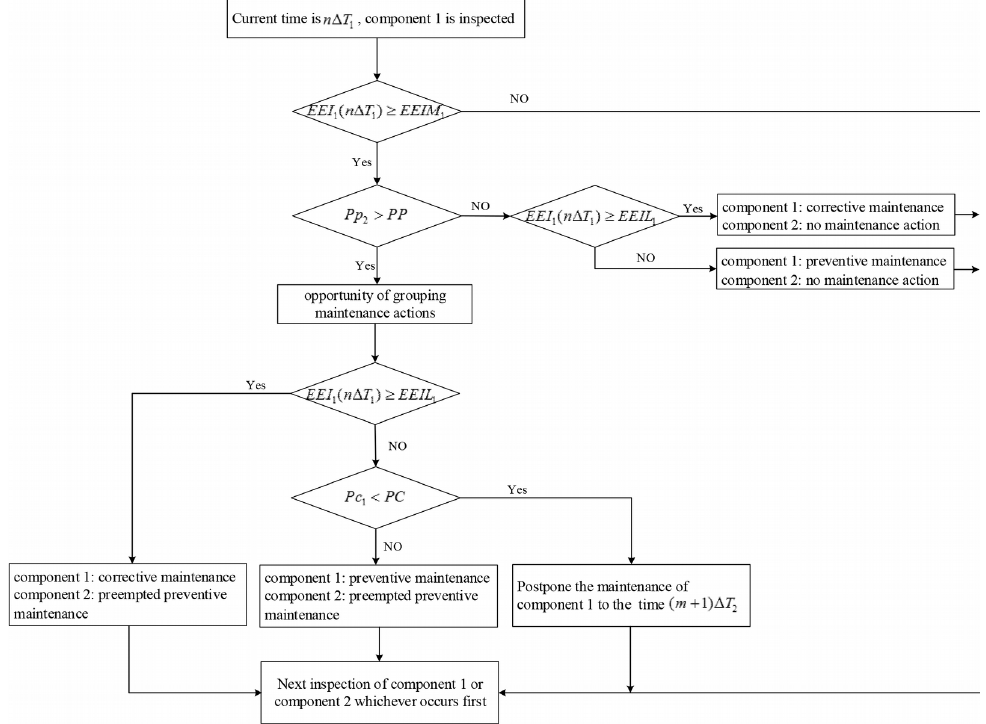
Figure 4. Decision rule of maintenance when component 1 is inspected at time n Δ T